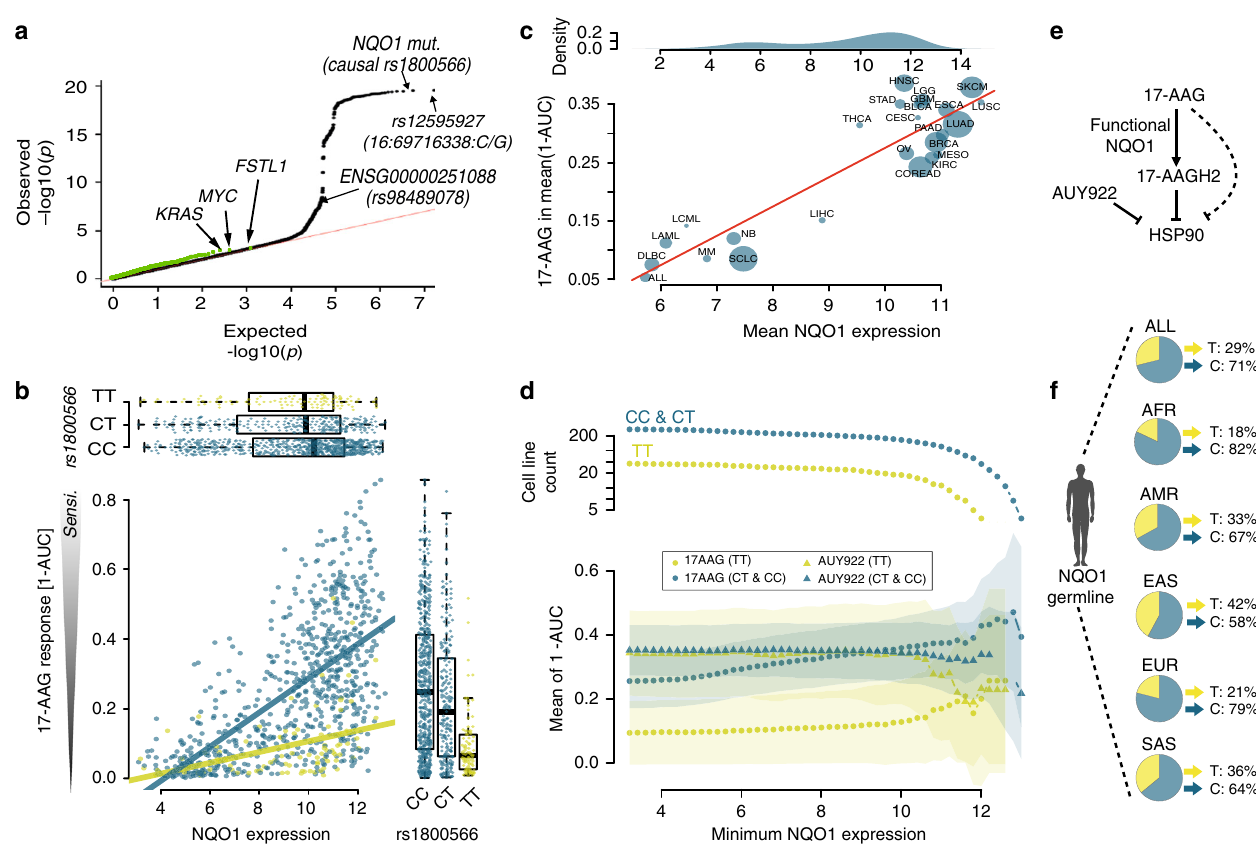
Fig. 3 The germline component of 17-AAG drug susceptibility. a Quantile – quantile plot of negative log P values from genome-wide association tests of 17- AAG susceptibility, considering germline variants (back) and somatic mutations (green). The most associated (lead) variant rs12595927 is in tight linkage disequilibrium with the known causal variant for this associations (rs1800566, e.g., ref. 18 , r 2 = 1 in European populations). b Scatter plot between NQO1 gene expression ( x -axis) and 17-AAG drug susceptibility ( y -axis). Dots correspond to individual cell lines strati fi ed by genotype at the rs1800566 locus (yellow: TT allele, blue: CC/CT allele). Box plots show the effect of the rs1800566 locus on gene expression (top panel) and drug susceptibility (right panel). Whereas NQO1 expression level is not associated with the germline variant, rs1800566 modulates the association between NQO1 expression level and drug susceptibility. The combination of high expression levels of NQO1 together with a CC or CT genotype is associated with the largest drug response. Boxes extend from the lower quartile (Q 1 ) of the data to the upper quartile (Q 2 ) of the data, whiskers show the range of the data (after excluding outliers), fl iers show outliers and the red lines show the medians. Outliers are de fi ned by the standard condition x < Q c Scatter plot between NQO1 expression level ( x -axis) and 17-AAG drug susceptibility ( y -axis), strati fi ed by tissue type. d Lower panel: Mean drug ef fi cacy of AUY922 and 17-AAG as a function of NQO1 expression and strati fi ed for rs1800566 genotype. Colours indicated the genotype group with triangles corresponding to AUY922 response and circles denoting 17-AAG response. Shaded areas indicate plus or minus one standard error of the mean drug response. Top panel: number of cell lines in strati fi ed groups. AUY922 is more effective than 17-AAG for low NQO1 expression. In cell lines with a CT and CC (rs1800566) germline background and high expression of NQO1 , the ef fi cacy of 17-AAG is comparable or larger than AUY922. e Mode of action for 17- AAG and AUY922. f Frequency of NQO1 germline variants in different human populations. Data for rs1800566 extracted from